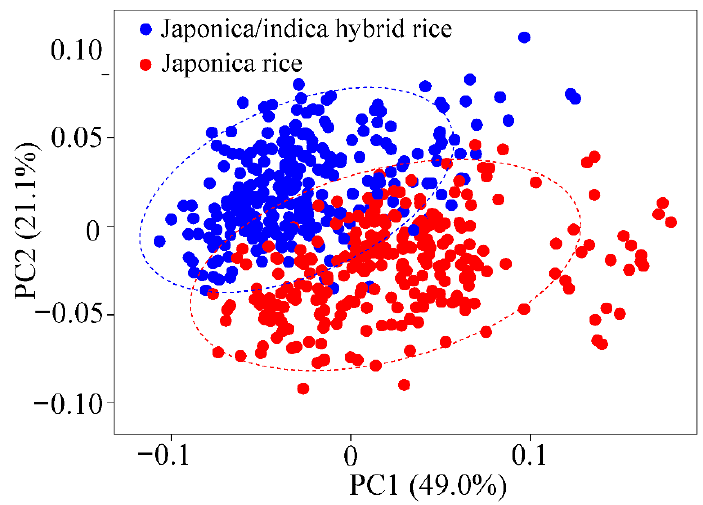
Figure 2. Principal component analysis (PCA) of the difference between japonica/indica hybrid rice and japonica rice based on the parameters in Table 1.